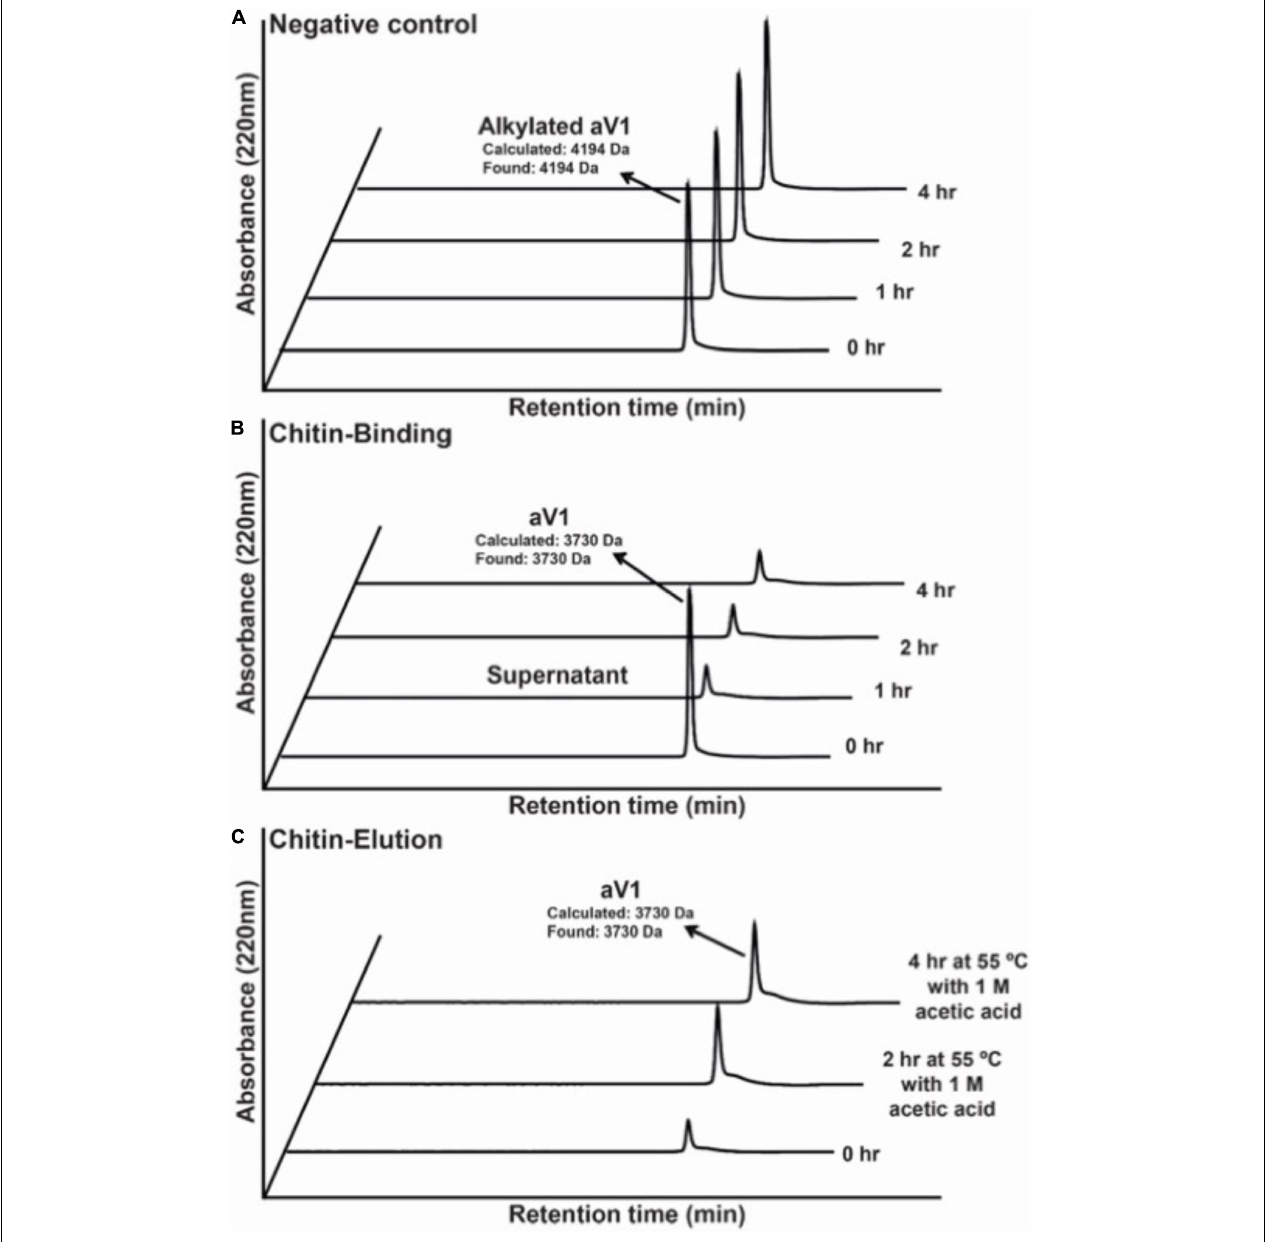
FIGURE 4 | Comparison of chitin-binding activities of (A) S -alkylated aV1 (iodoacetamido-) and (B) avenatide aV1 (iodoacetamido-) using chitin resins. The supernatants were analyzed by RP-HPLC. (C) Elution profile of avenatide aV1 from chitin resin using 1M acetic acid at 55 ◦ C. The supernatants were analyzed by